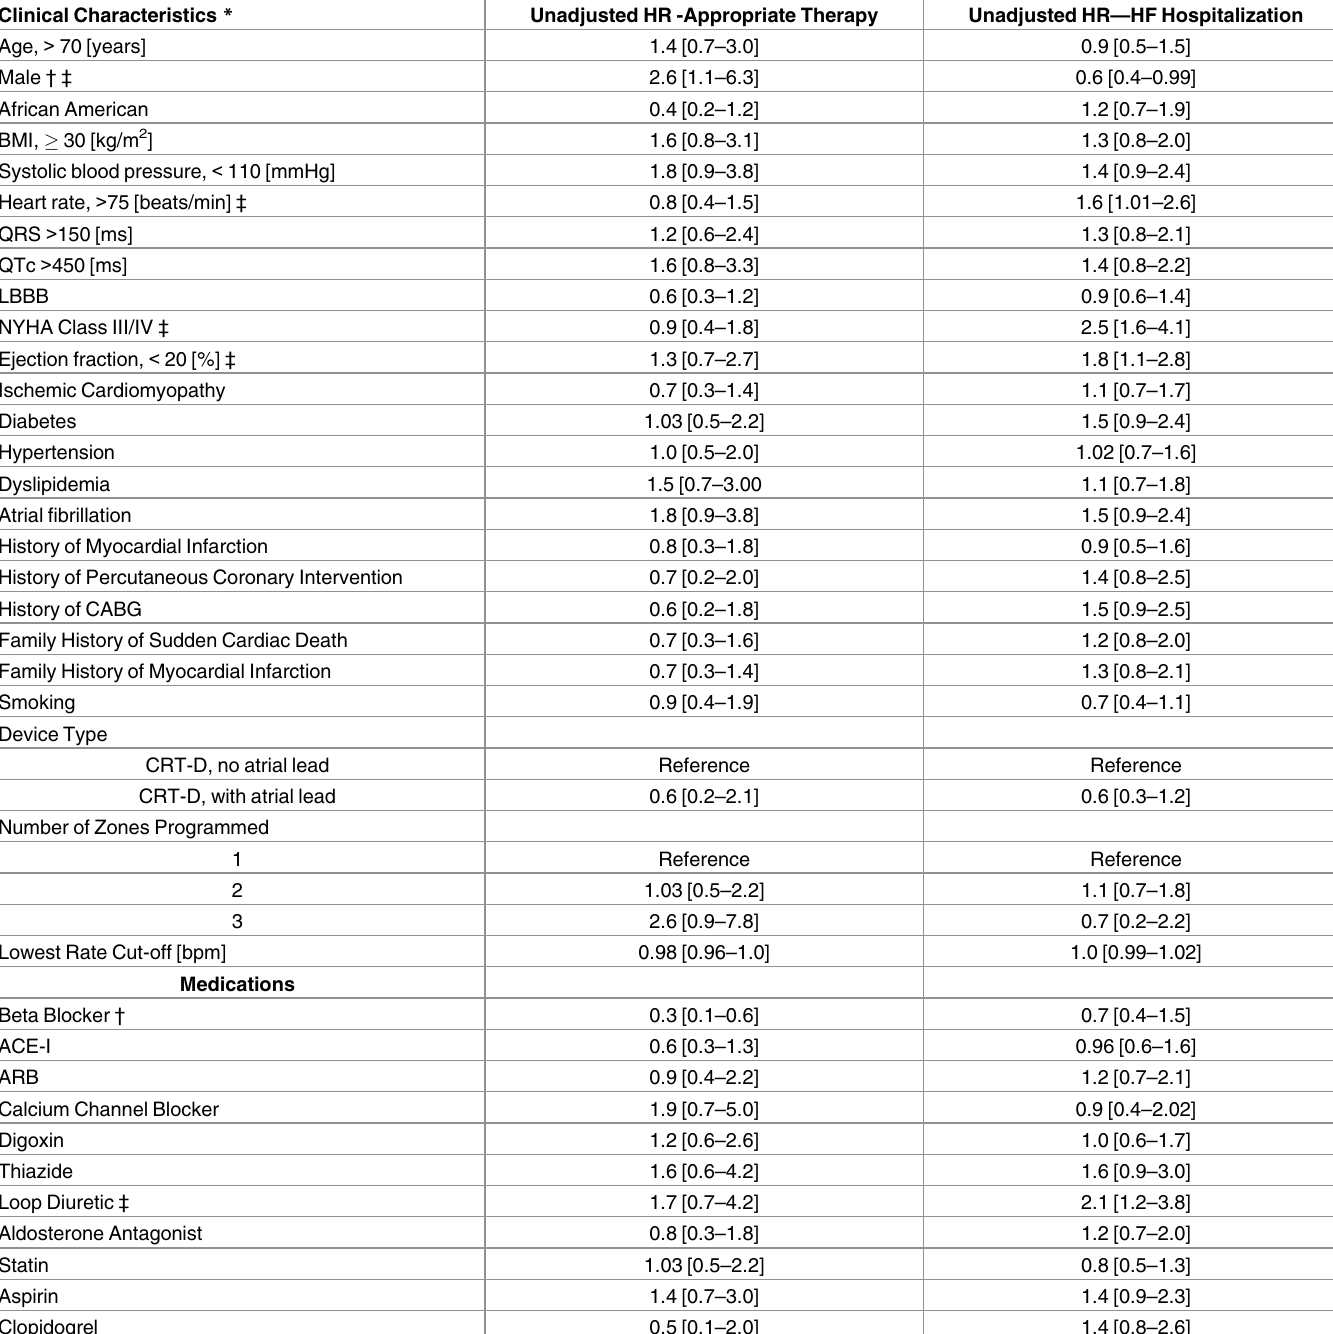
Table 2. Unadjusted hazard ratios [HR] for appropriate therapy and HF hospitalization–clinical characteristics and